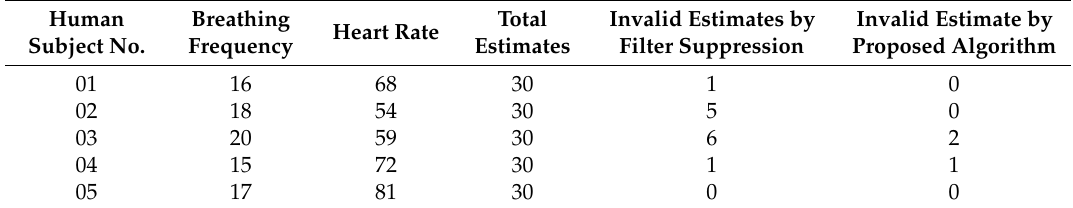
Table 3. Accuracy of proposed algorithm compared to conventional algorithm for different persons. Human